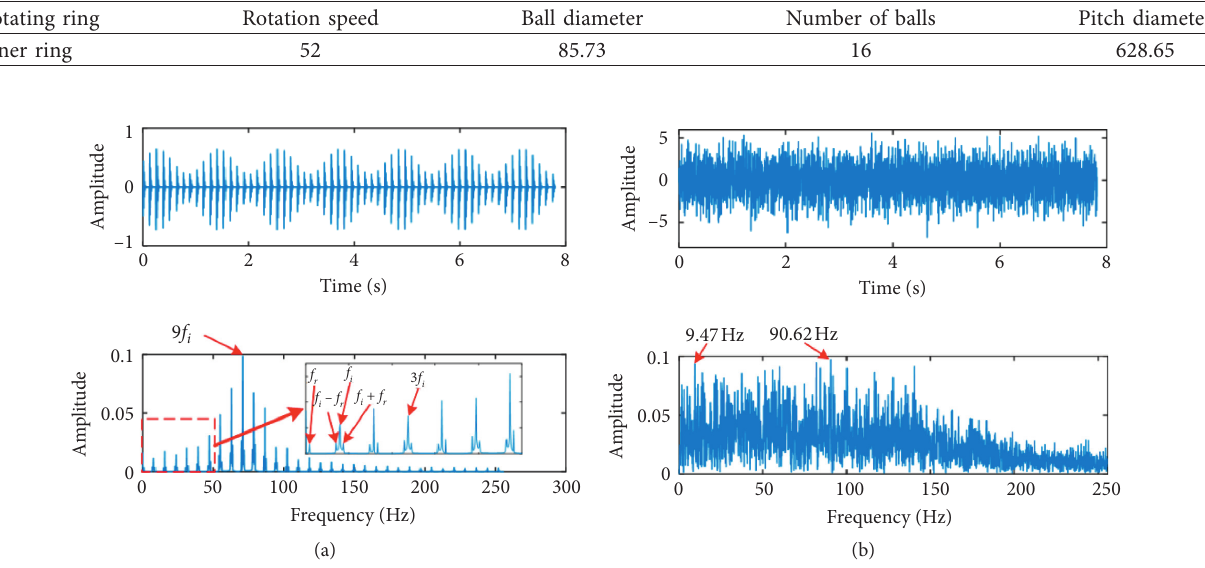
Table 1: The parameter of the hoist bearing SKF241/630 CAK/W33.